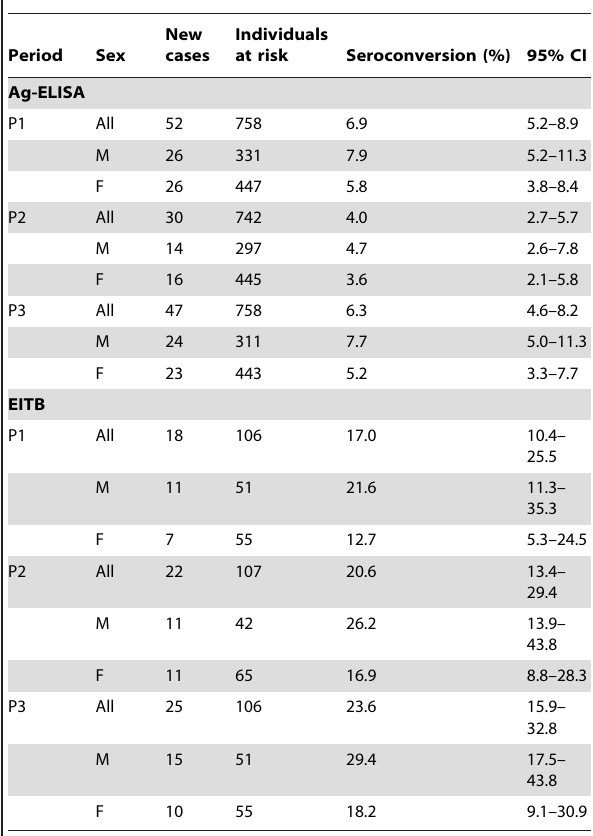
Table 2. Seroconversion rates of human cysticercosis in function of sex for both circulating antigen and specific antibody